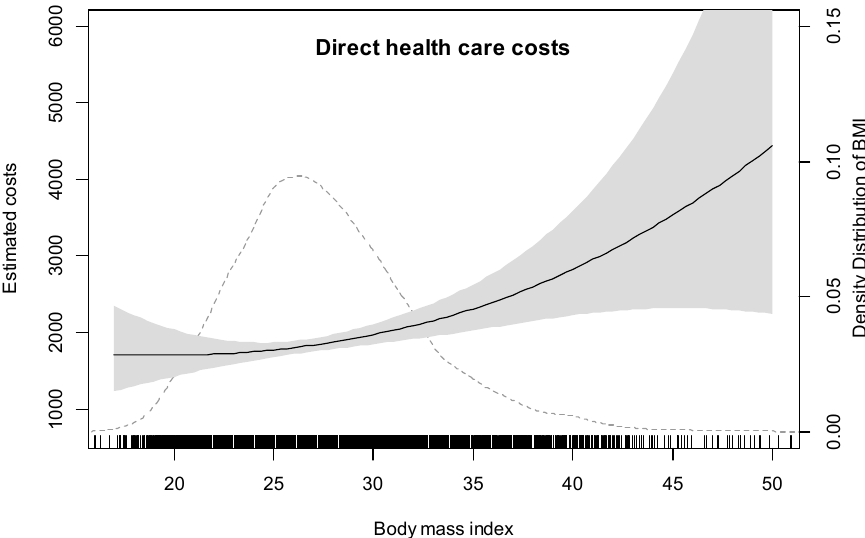
Figure 1. Relationship between BMI and direct health care costs. Footnote: The solid curve represents the estimated smooth functions of the non-linear association between BMI and direct health care costs using a thin plate regression spline function adjusted for age, age 2 , gender, education level, and income. The shaded areas represent approximate 95% pointwise confidence intervals. The dotted line represents the density distribution of BMI in the sample.